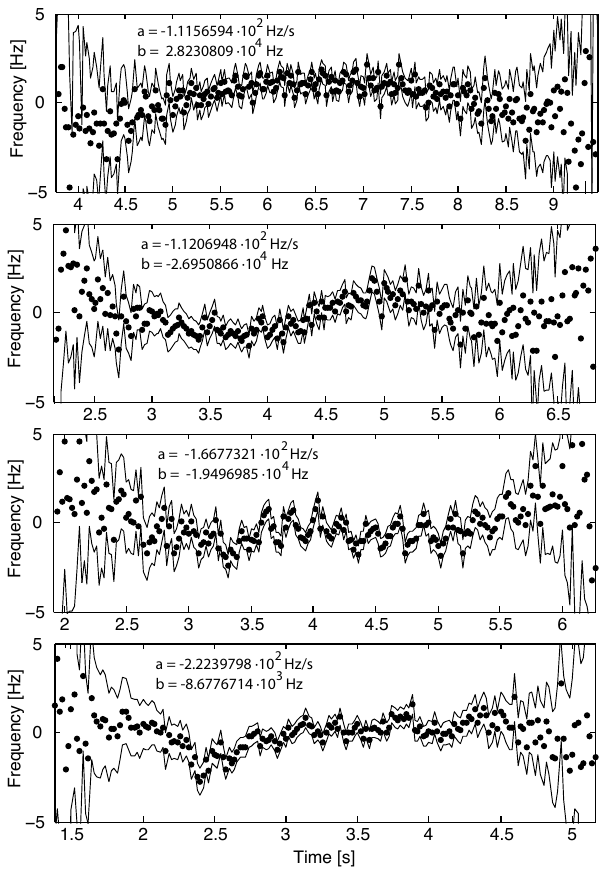
Fig. 3. Detrended Doppler frequencies from four beam passes (dots), together with 3 σ limits (continuous lines). Time is mea- sured from the start of each measurement. The subtracted trend is ν L = a · t + b with the numbers given in each